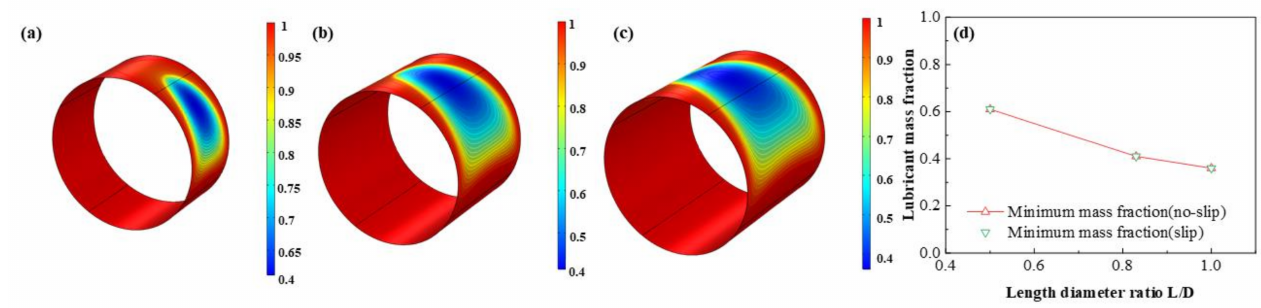
Figure 14. Comparison of the liquid mass fraction distribution under different length diameter ratios. ( a ) L / D = 0.5; ( b ) L / D = 0.83; ( c ) L / D = 1.0; ( d ) minimum liquid mass